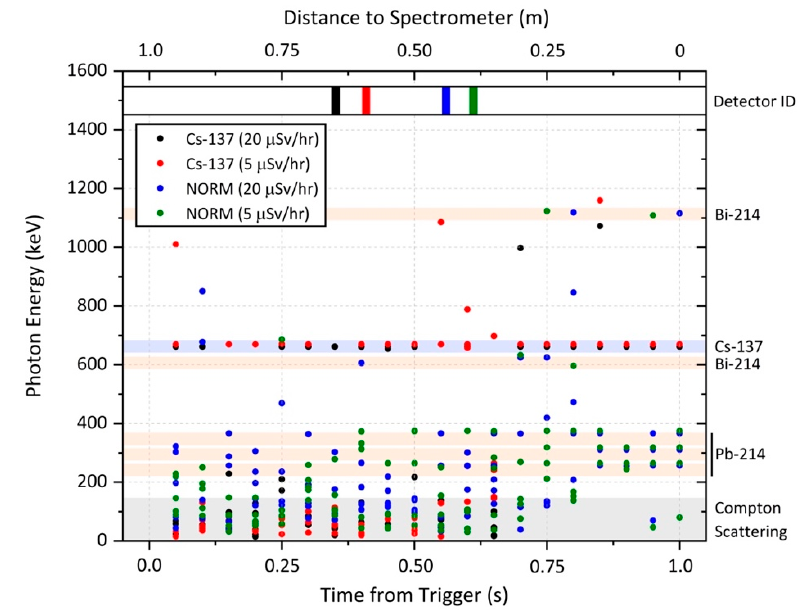
Figure 8. Analysis of the integrated spectrometer response to four trial radioactive sources (Cs-137 and NORM) transited through the gate. The “time from trigger” represents the duration from the IR sensor at the front.